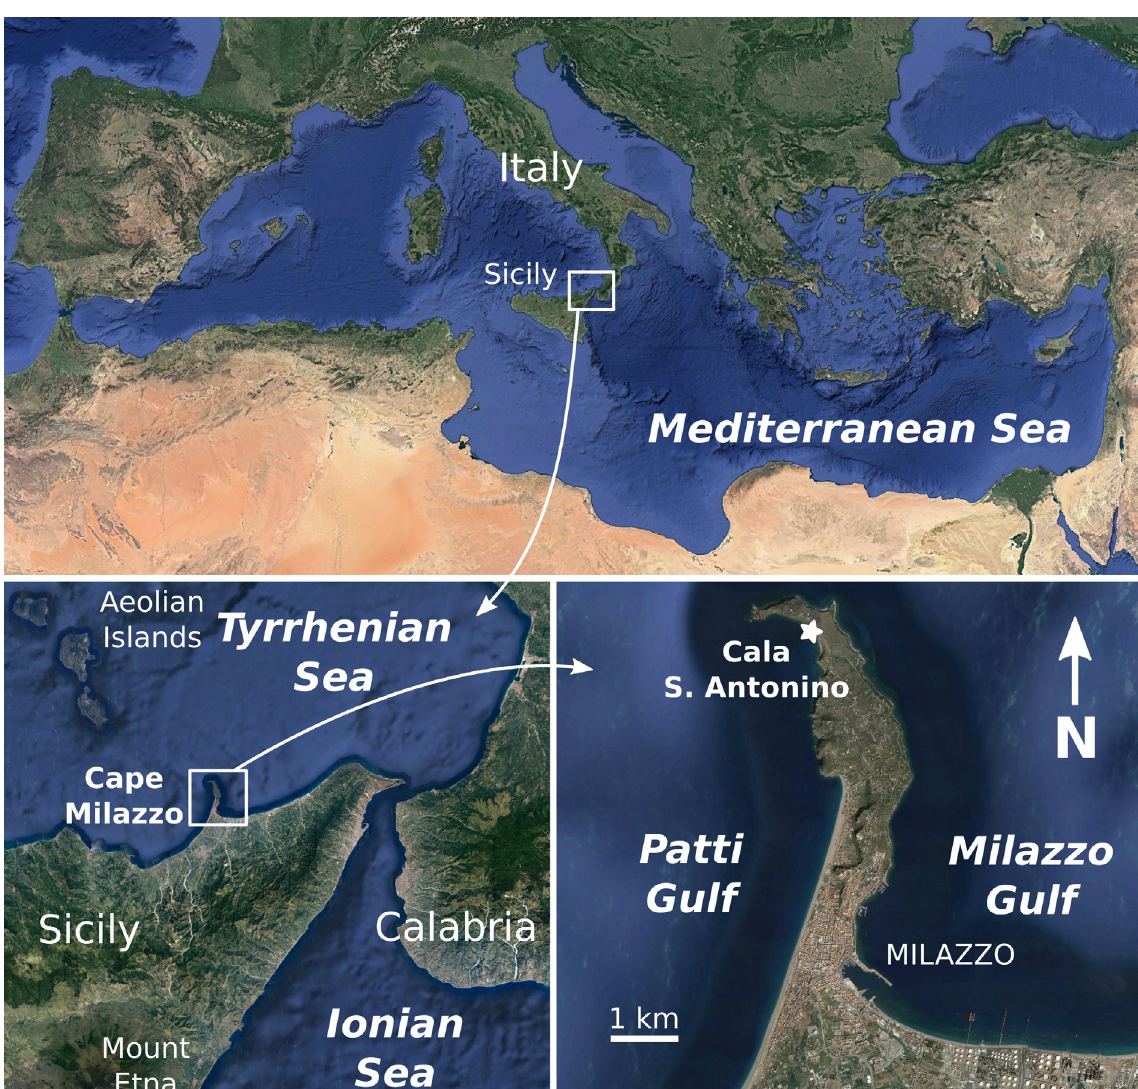
Fig. 1. Locality map, showing provenance (white star) of the holotype of the new platylepadid (MSNC 4562) described herein. All images from